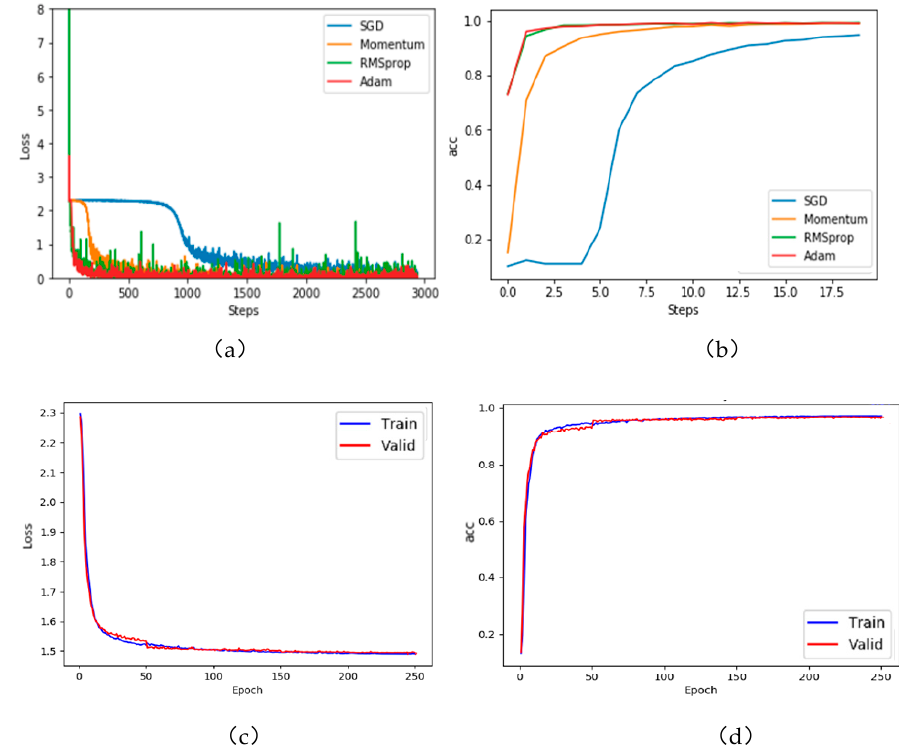
Figure 7. ( a ) Loss function curves of the training set. ( b ) Recognition rates. ( c ) Loss functions and ( d ) accuracies of the training and test set obtained in the fivefold cross-validation. Table 2. Recognition rates and training times of di ff erent